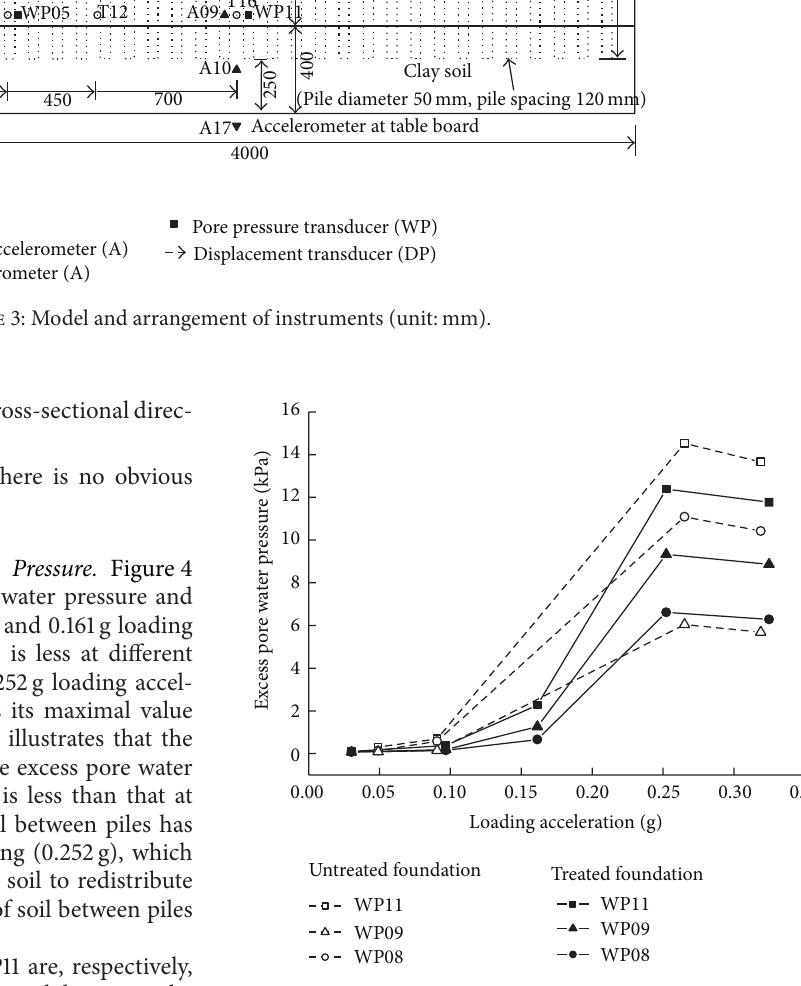
Figure 4: The relation between excess pore water pressure and loading